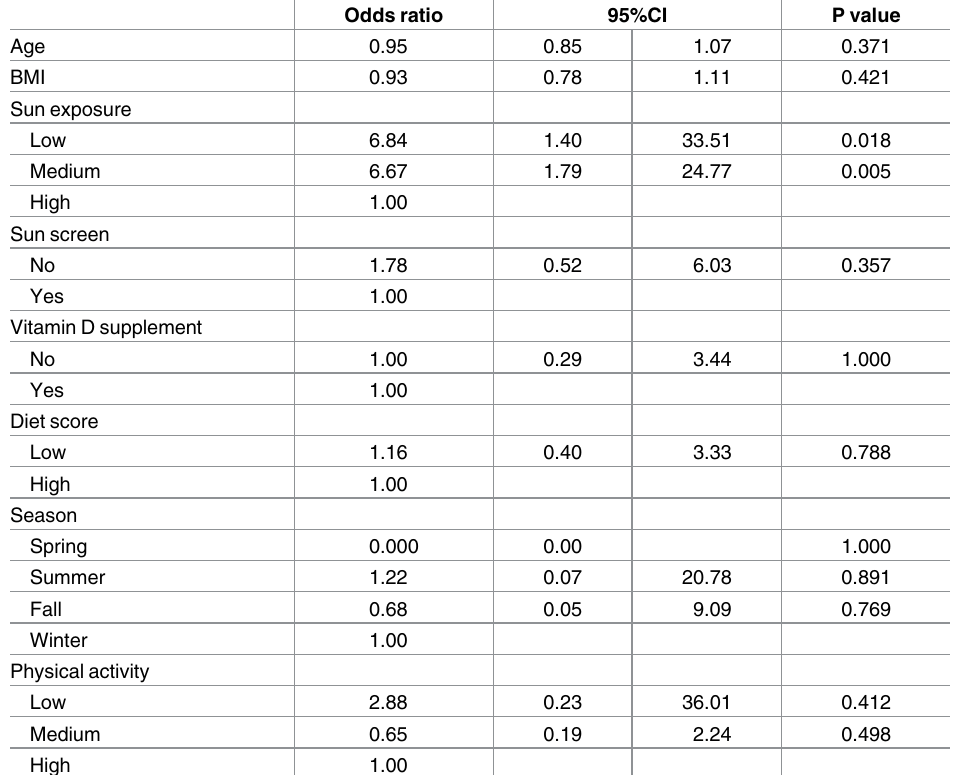
Table 4. Logistic regression for risk factors of low vitamin D status